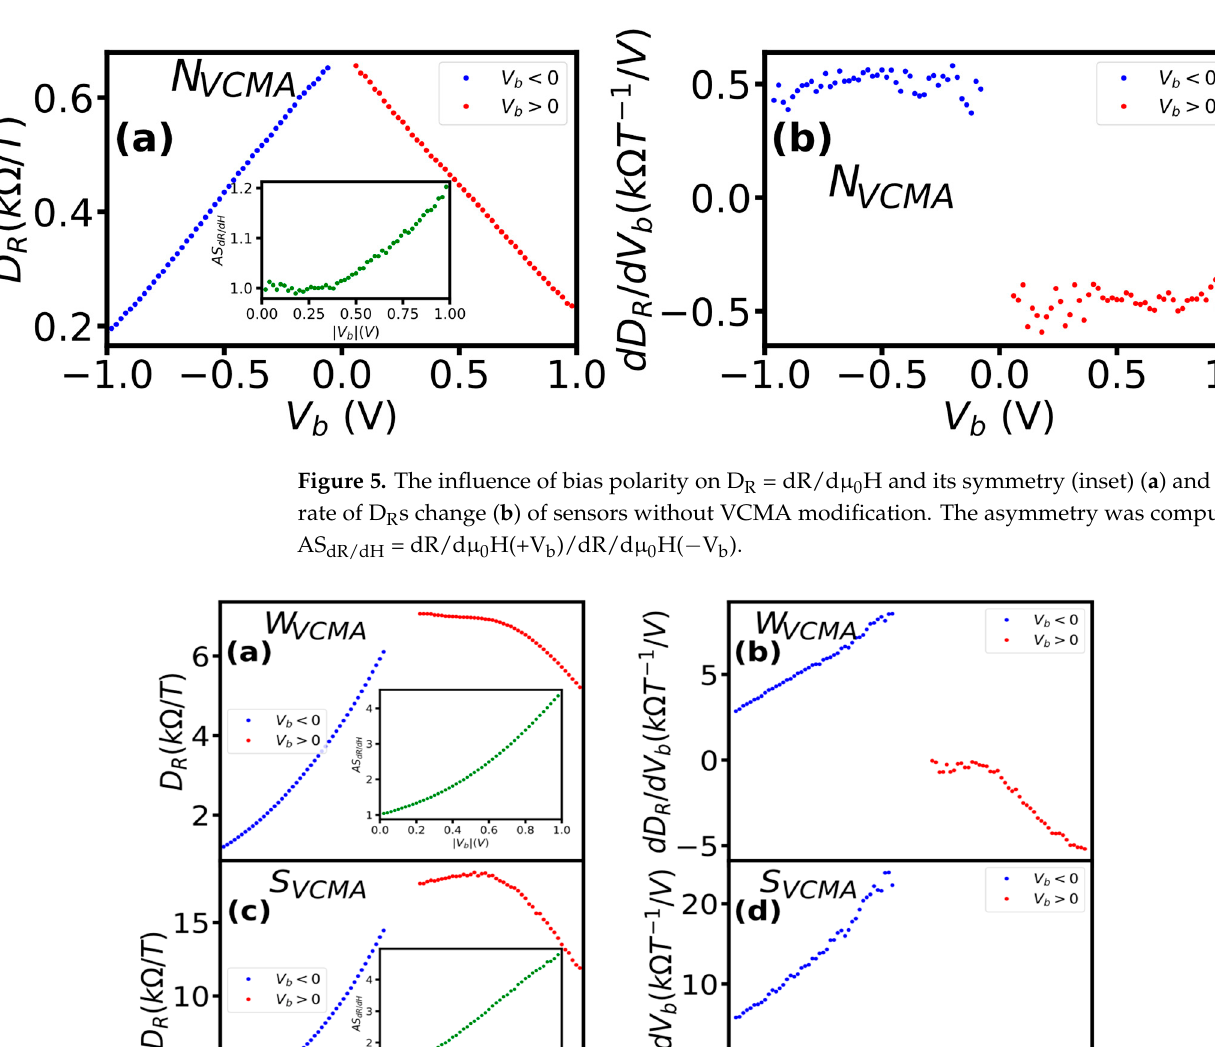
Figure 4. The influence of bias polarity on dI/dV characteristics and their symmetry (inset) of sensors without ( a ), with medium ( b ) and strong ( c ) VCMA modification. The asymmetry was computed as AS Gd = G d (+V b )/G d ( − V b ).